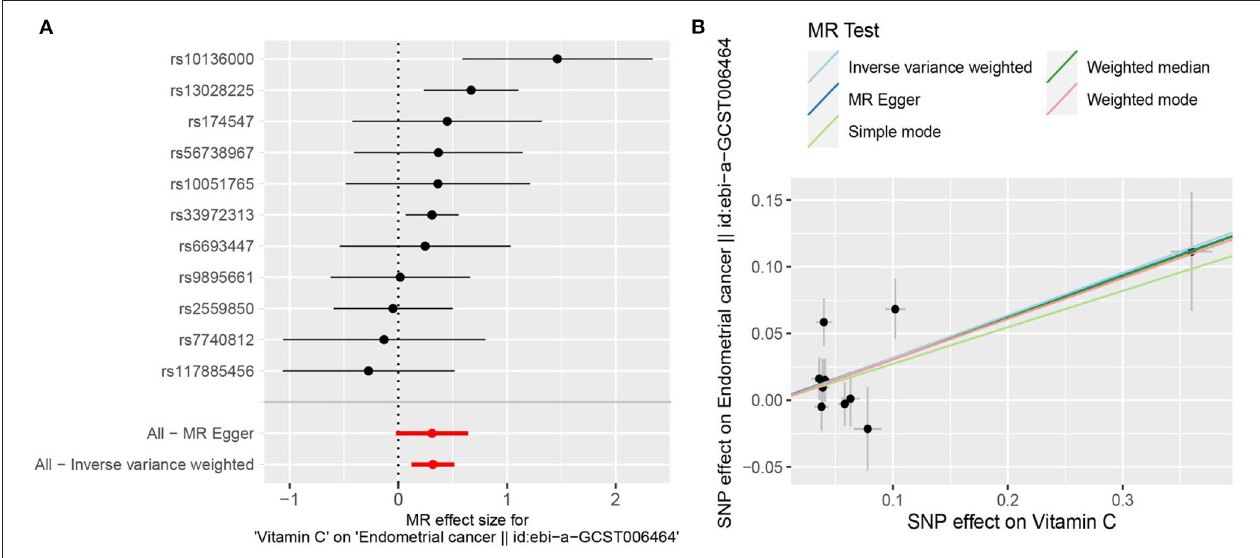
FIGURE 2 | Mendelian randomization estimating the effects of genetically predicted higher plasma circulating vitamin C (VitC) levels (per 1 SD increase, ∼ 20 µ mol/L) on the risk of endometrial cancer (EC). (A) Forest plot of single nucleotide polymorphisms (SNPs) associated with higher circulating VitC levels and their risk of EC. (B) Scatter plots of SNPs correlated with higher circulating VitC concentrations and their risk of